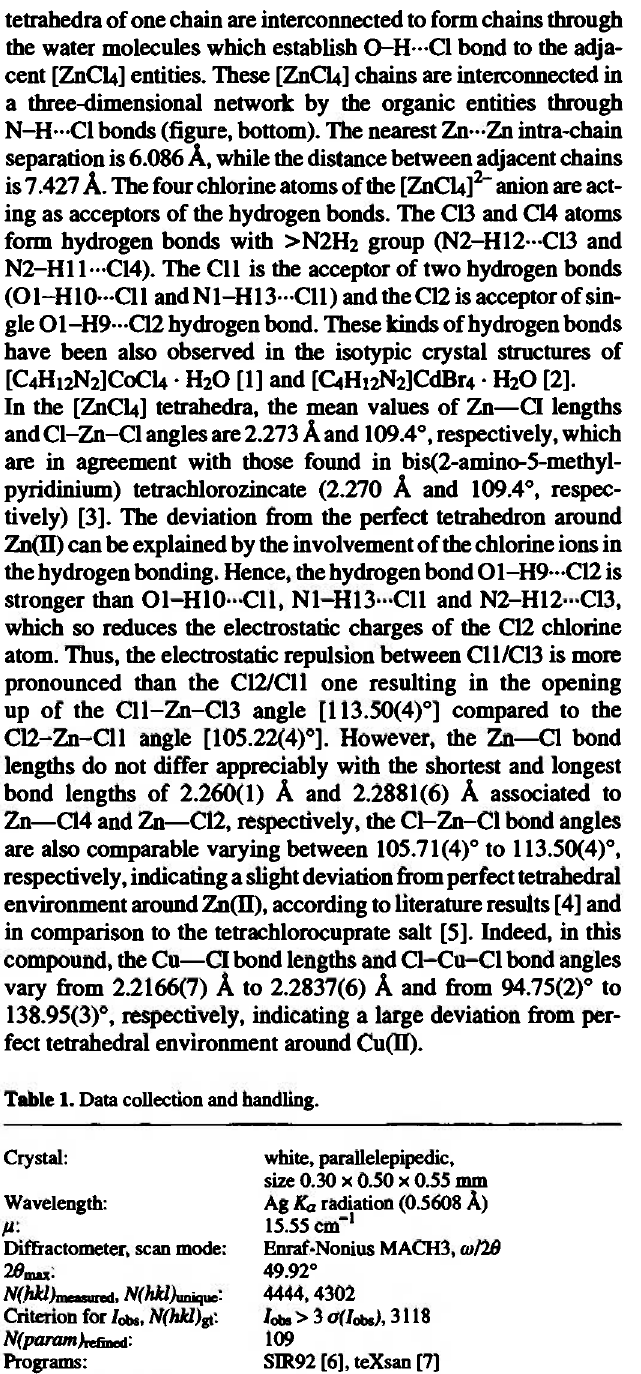
Table 1. Data collection and